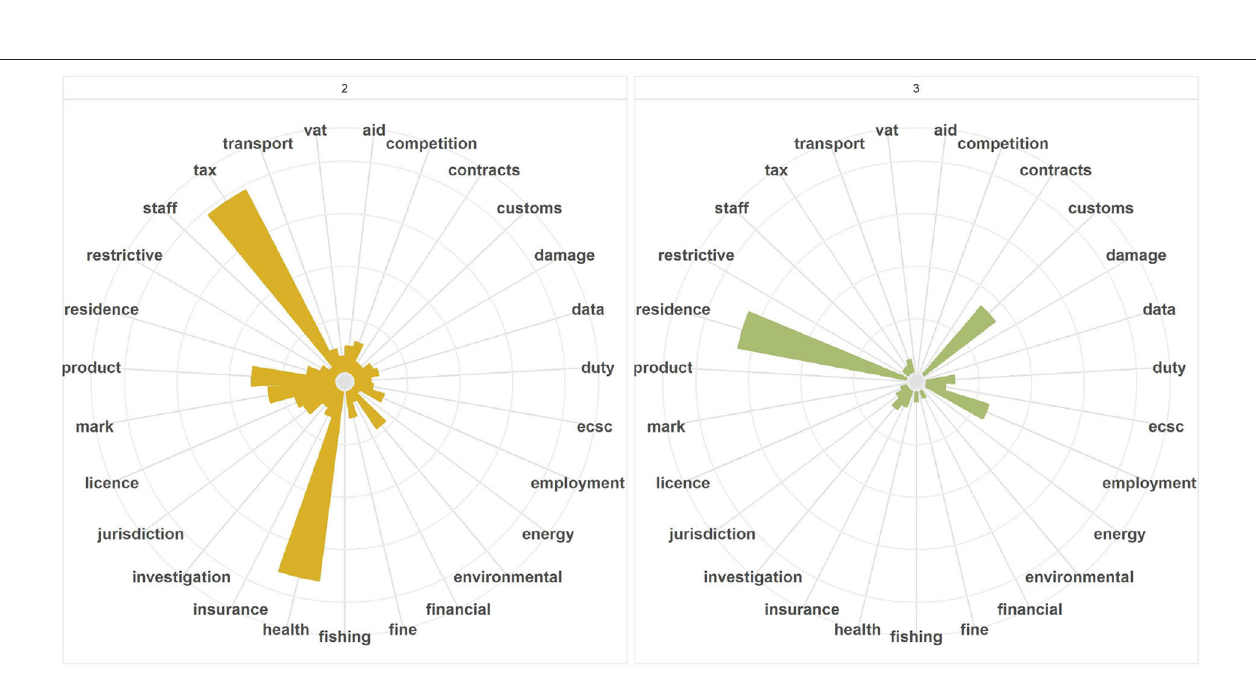
Frontiers in Physics |